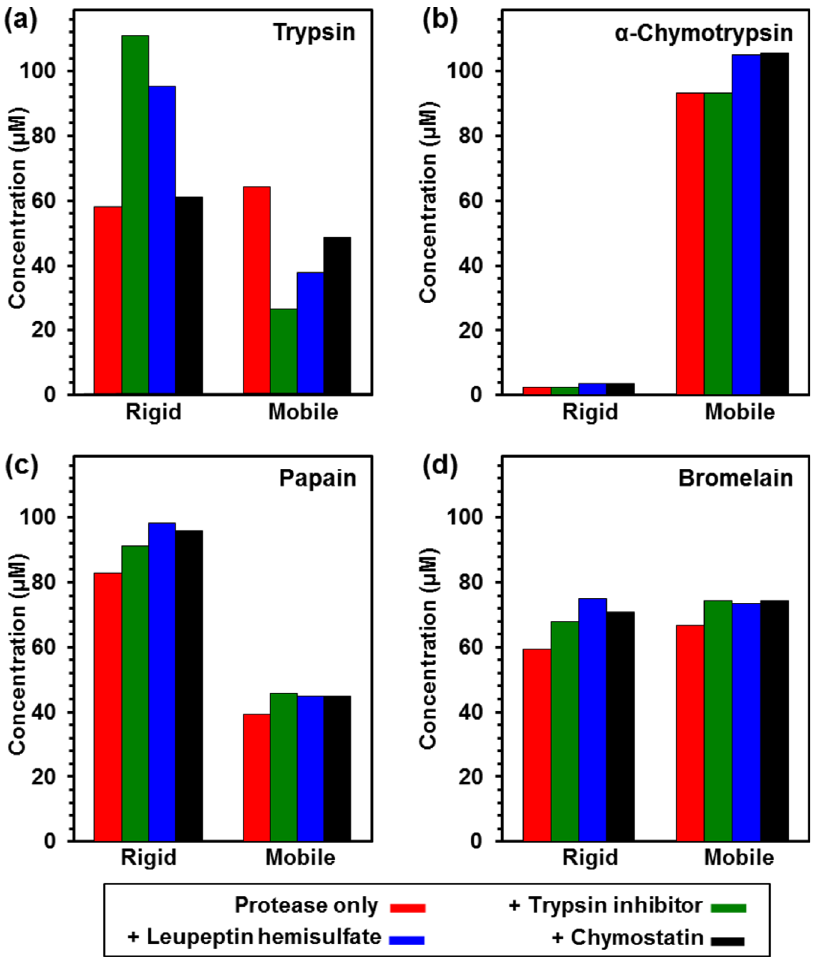
Figure 7. Rigid and mobile population concentrations following a 24-hour, room-temperature digestion of BSA by four proteases: Trypsin, a -chymotrypsin, papain, and bromelain. Each protease acted alone or in the presence of three known protease inhibitors. Total substrate concentration was 160 l